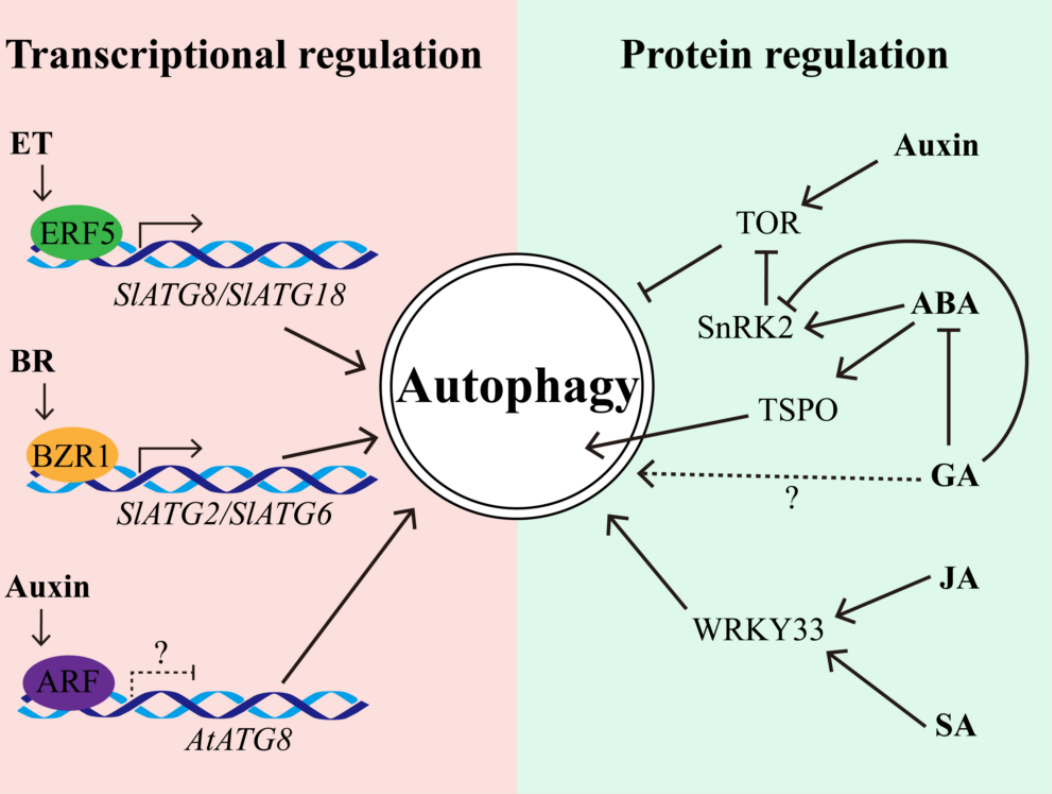
Figure 2. Regulation of autophagy by plant hormones. Phytohormones can modulate autophagy at the transcriptional level and through protein regulations. In respect to the former, the transcription factors ethylene response factor 5 (ERF5) in ethylene pathway and brassinazole-resistant 1 (BZR1) in the brassinolide (BR) pathway directly bind to the corresponding ATG promoters and then activate gene expression to promote autophagy. In contrast, the auxin regulator auxin response factor (ARF) also likely binds to the AtATG8 promoter to repress its expression, eventually leading to attenuating autophagy activity. In addition, auxin also can repress autophagy by promoting target of rapamycin (TOR) activity. On another hand, abscisic acid (ABA) can promote the SnRK2 and TSPO to positively regulate autophagy. By contrast, gibberellin (GA) seems to antagonize ABA in regulating autophagy through inhibiting SnRK2 activity. Alternatively, GA may also directly modulate autophagy through an unknown component. Jasmonic acid (JA) and salicylic acid (SA) induce the expression of WRKY33 , and then WRKY33 directly triggers the expression of ATG genes, consequently promoting autophagy. Solid lines represent the activation or repression with known evidence. Dashed lines represent the proposed activation or